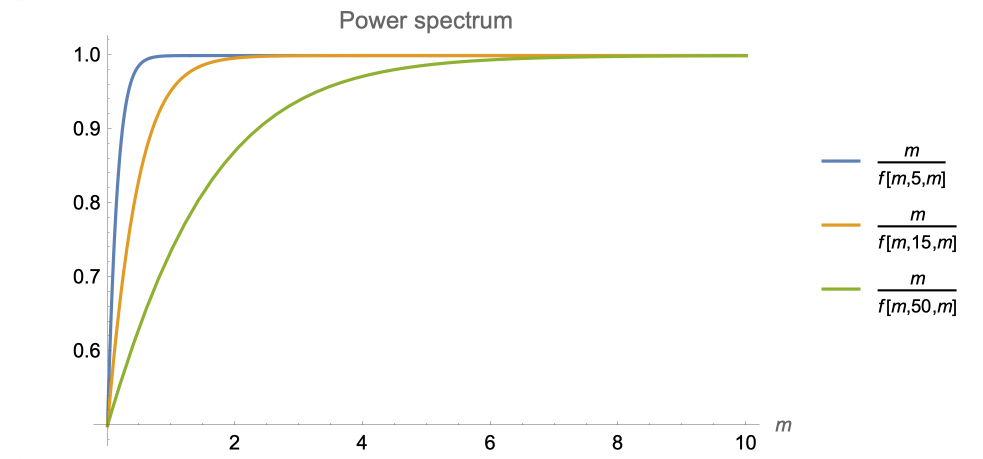
Figure 5 . The plot for the ratio m shows that the departure from scale invariance in the f [ m,b,m ] scalar two-point function persists for modes with momentum m < ∼ b